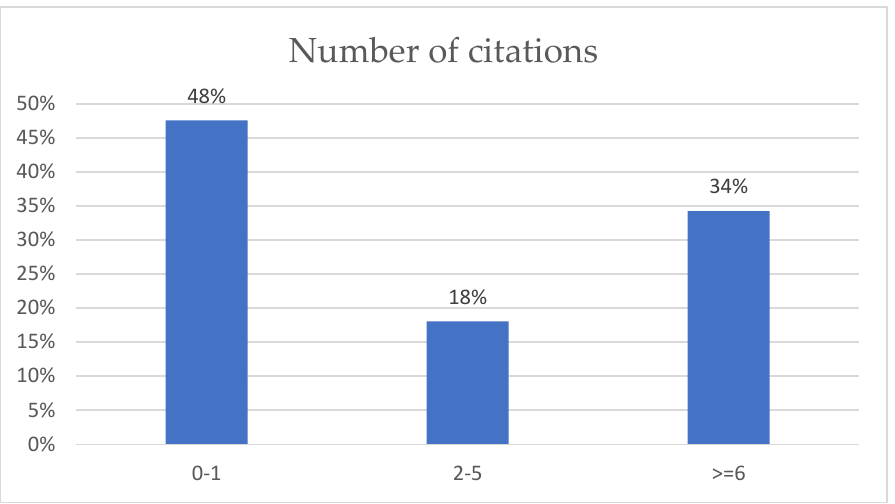
Figure 1. Indoor infrastructure components reported in papers published between 2017 and 2022.